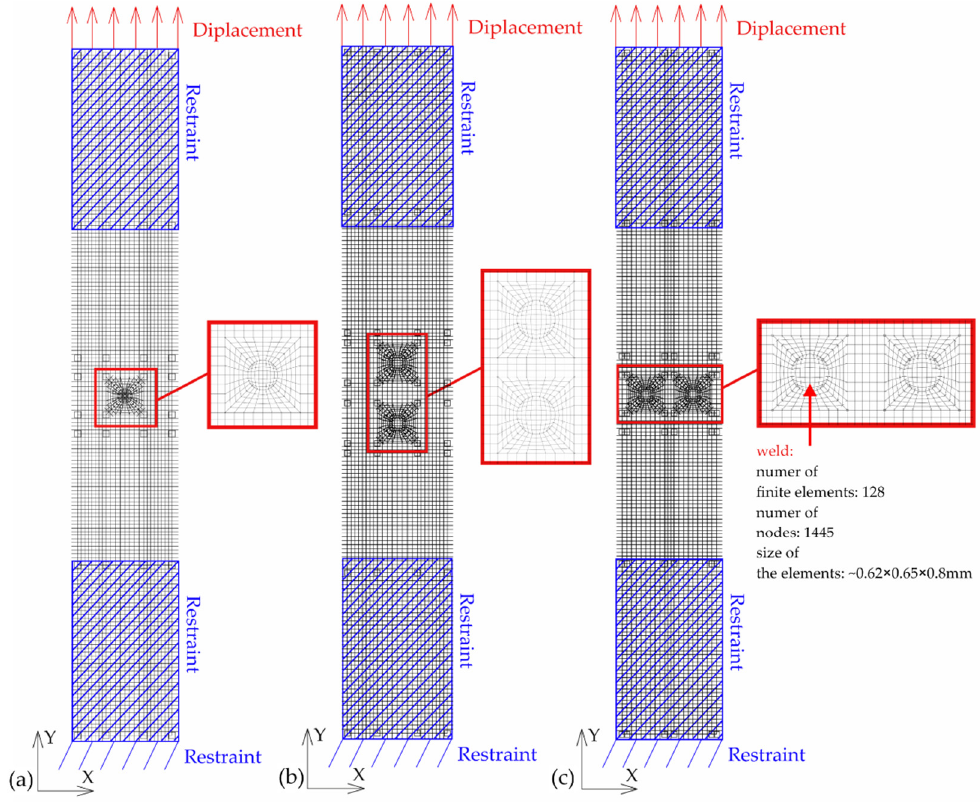
Figure 3. Numerical model with FEM mesh: ( a ) joints with single weld; ( b ) joints with two welds— parallel to the direction of tensile shear and ( c ) joints with two welds—perpendicular to the direction of tensile–shear. Table 5. The total number of finite elements and nodes of the models.